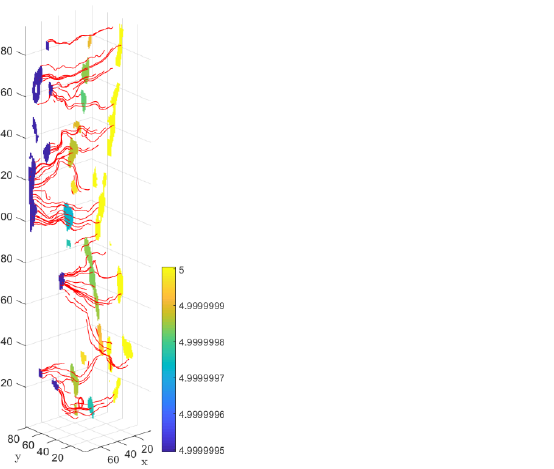
Figure 6. Distribution of density in lattice units and streamlines at steady state in the shale sample at 𝐾𝑛(cid:3562) = 0.045 .